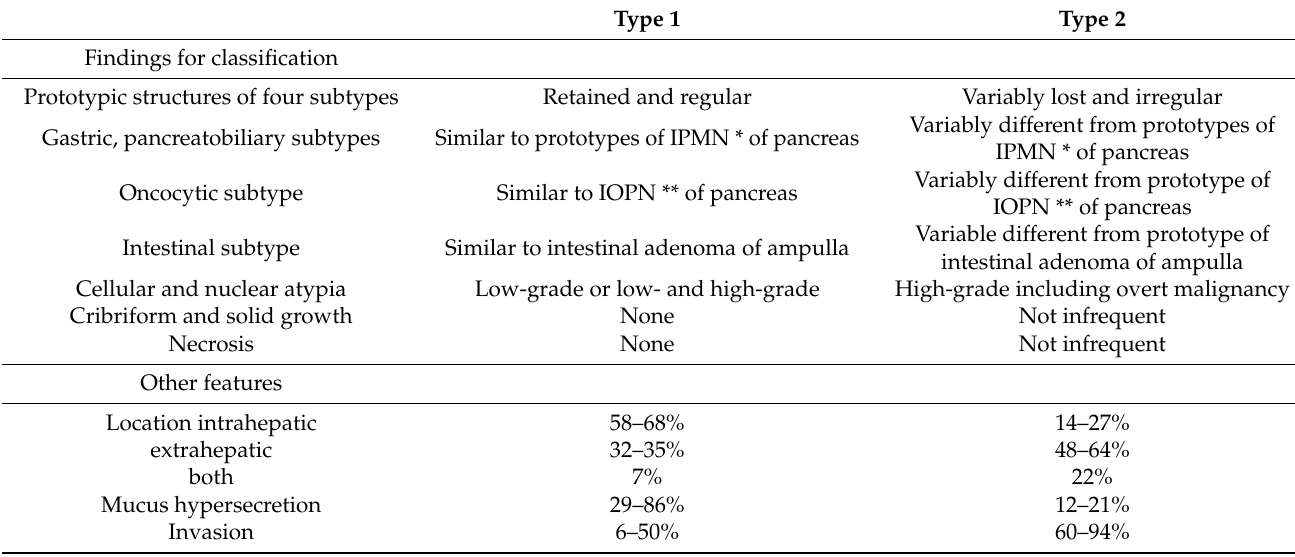
Table 5. Characteristic features of modified two-tiered grading (type 1 and type 2 subclassification) of IPNB (intraductal papillary neoplasm of bile